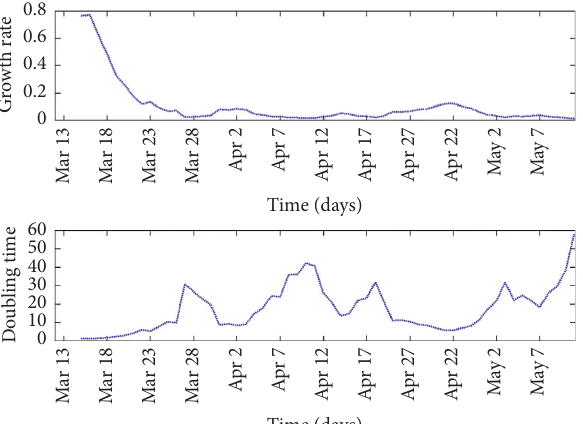
Figure 5: Growth rate and doubling time for COVID-19 cases from 14 th March to 11 th May 2020, Sri Lanka (source: Epidemiology Unit, Ministry of Health, Sri